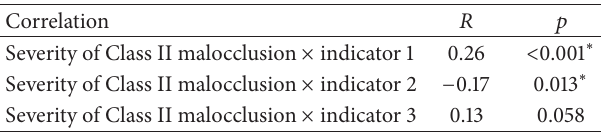
Table 3: Spearman correlation analysis of the relationship between the severity of Class II malocclusion and the molar rotation.